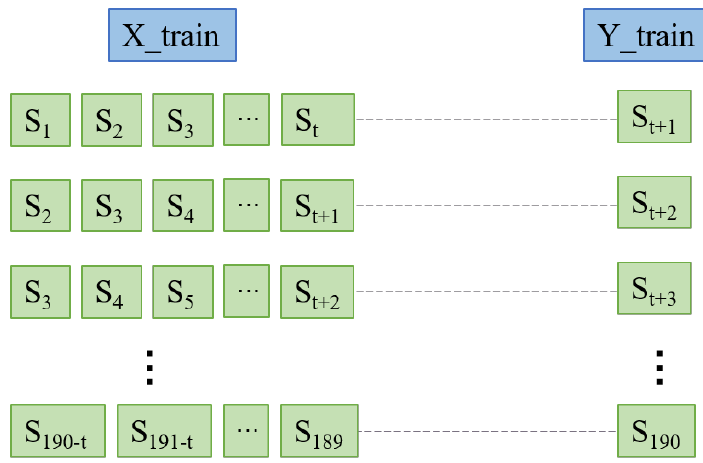
Figure 6. Divide training datasets and validation datasets.